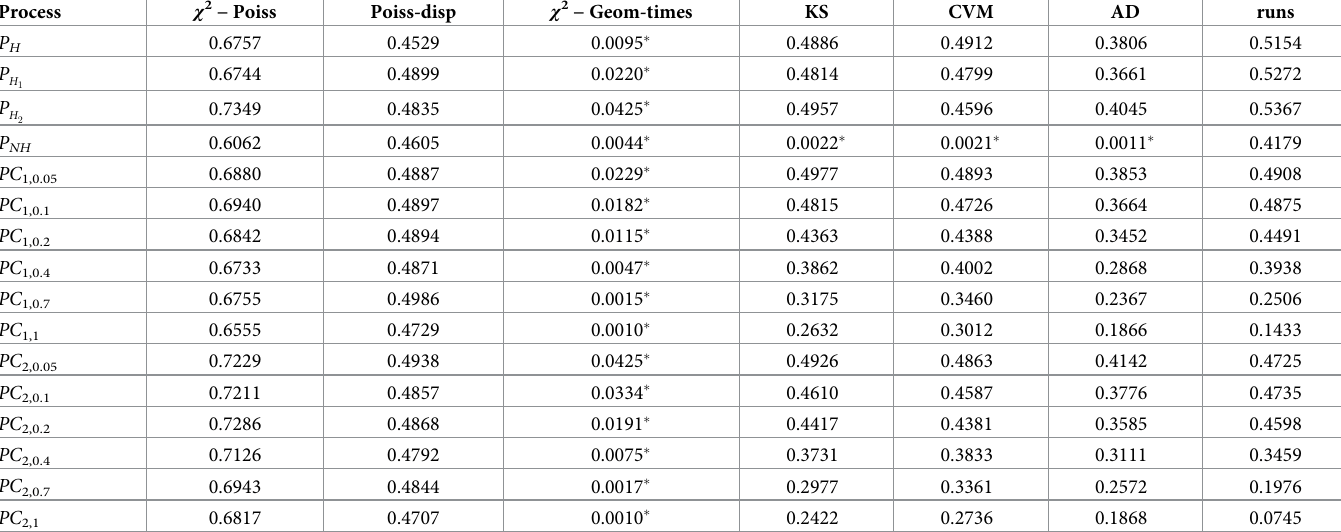
Table 6. Medians of 500 p-values of different test for the simulated processes. Significant differences ( α = 0.05) are identified with an asterisk ( � ). Process χ 2 − Poiss